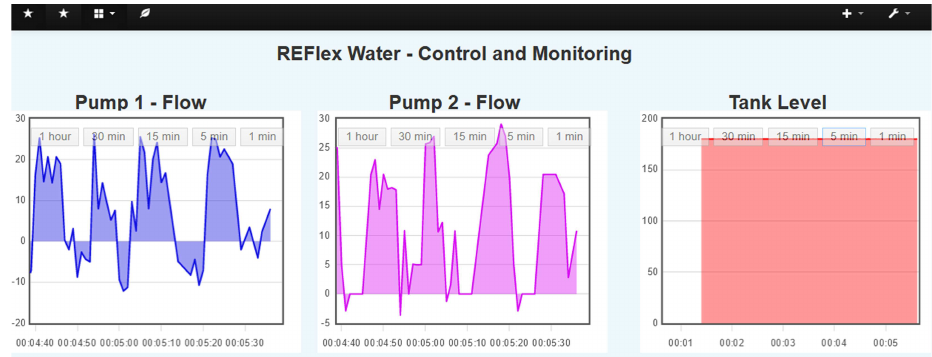
Figure 12. A scenario for the REFlex Water framework.